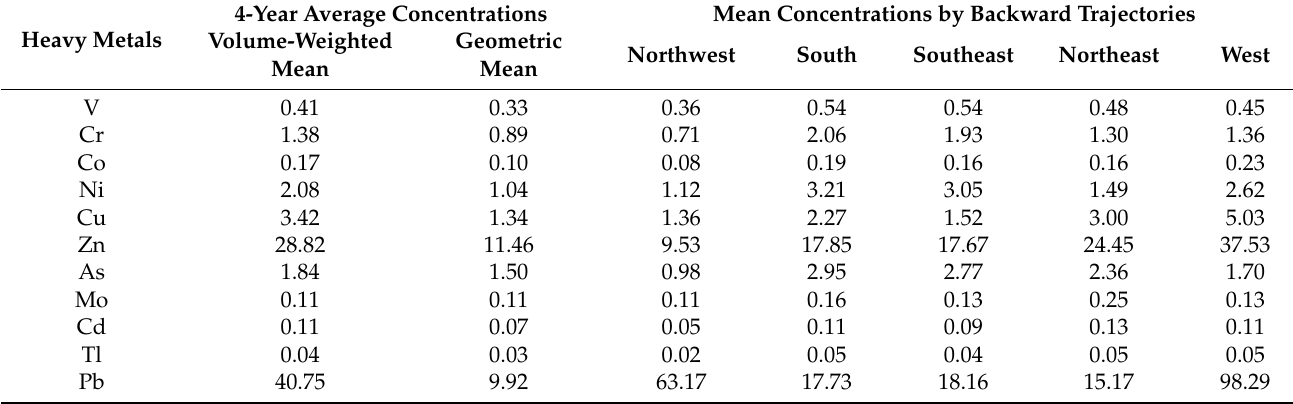
Figure 2. The seasonal variations of rainfall amount ( a ) and selected heavy metals and metalloids (MMs, ( b ) = V, ( c ) = Cr, ( d ) = Co, ( e ) = Ni, ( f ) = Cu, ( g ) = Zn, ( h ) = As, ( i ) = Mo, ( j ) = Cd, ( k ) = Tl, ( l ) = Pb) in bulk rain during 2017–2020 (SP = spring, SU = summer, AU = autumn, WI = winter). Box and whisker plot showing the maximum and minimum values (whiskers), the upper and lower quartiles (boxes) and the median (middle horizontal bolded line). Circles denote outliers beyond the whiskers. The data in autumn and winter 2016 ( n = 2) was not included. Table 1. The volume-weighted average and geometric mean concentrations ( μ g L − 1 ) of 11 MMs in bulk rain depositions observed during 2016–2020. The mean concentrations were also calculated according to air mass back-trajectory showing possible source directions.